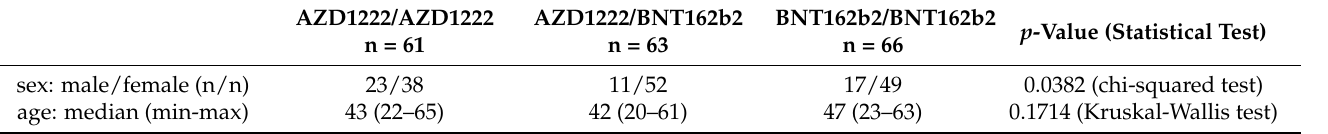
Table 1. Patients’